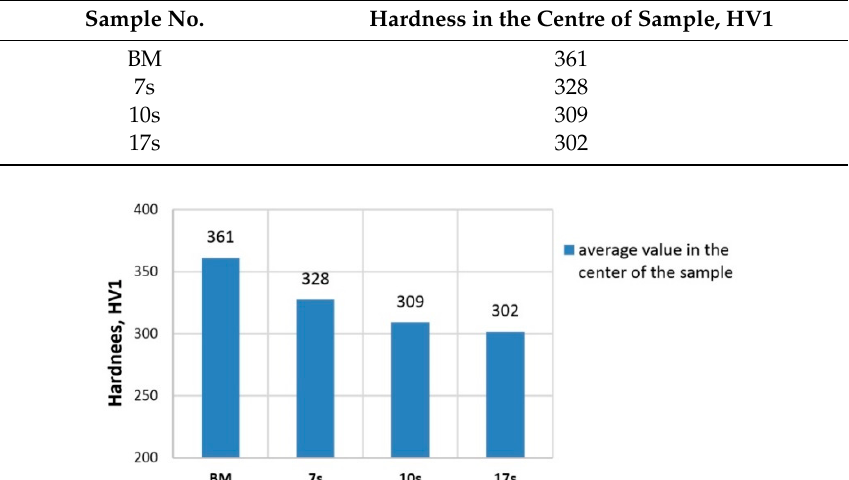
Table 5. Result of the hardness test for the base material and the samples affected by the thermal cycle under different cooling times t 8/5 .